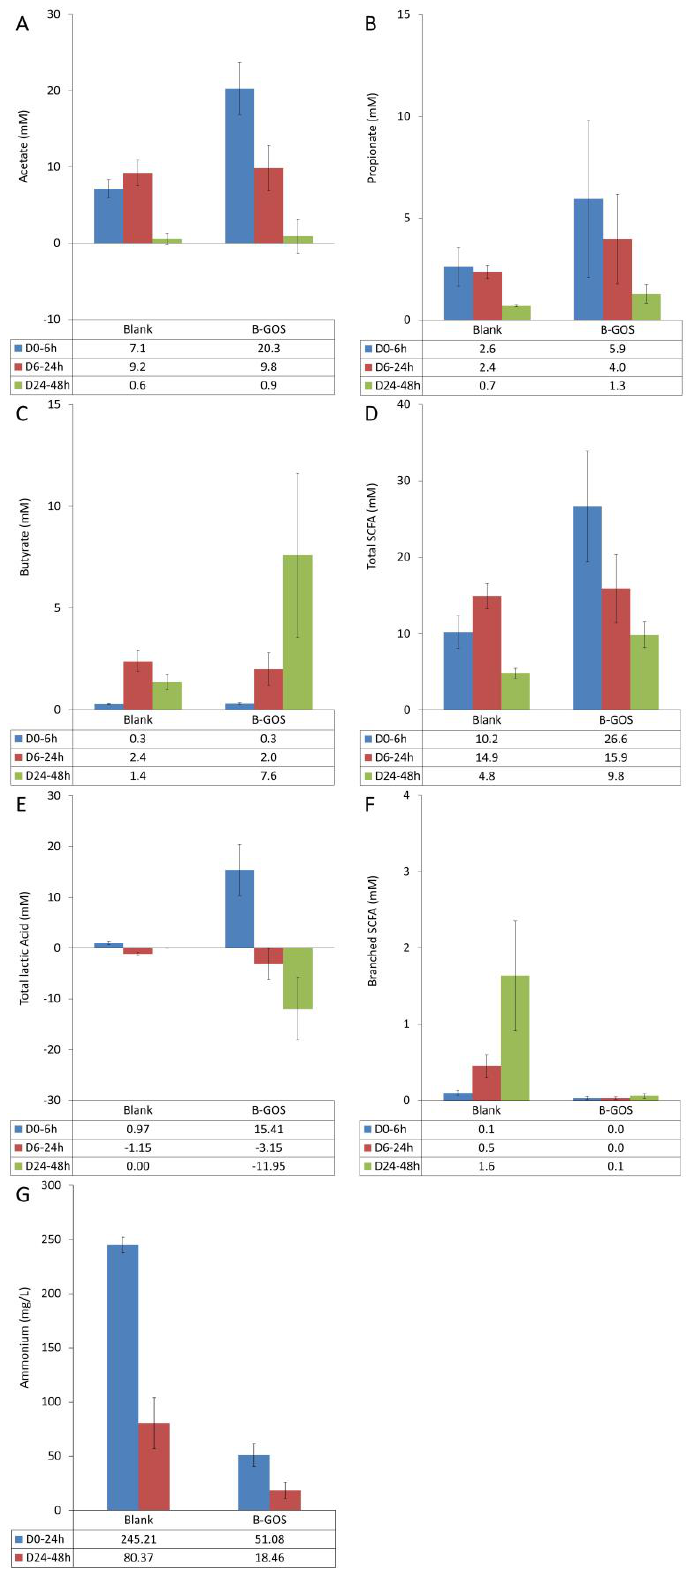
Figure 3. Microbial metabolic activity ( A ) acetate, ( B ) propionate, ( C ) butyrate, ( D ) total SCFA, ( E ) lactate, ( F ) branched SCFA, and ( G ) ammonium. Measurements were collected in triplicate. Data for average values were derived using data from Donors A/B/C. Error bars represent standard deviation. GOS = Bimuno ® galactooligosaccharide; SCFA = short-chain fatty acid.